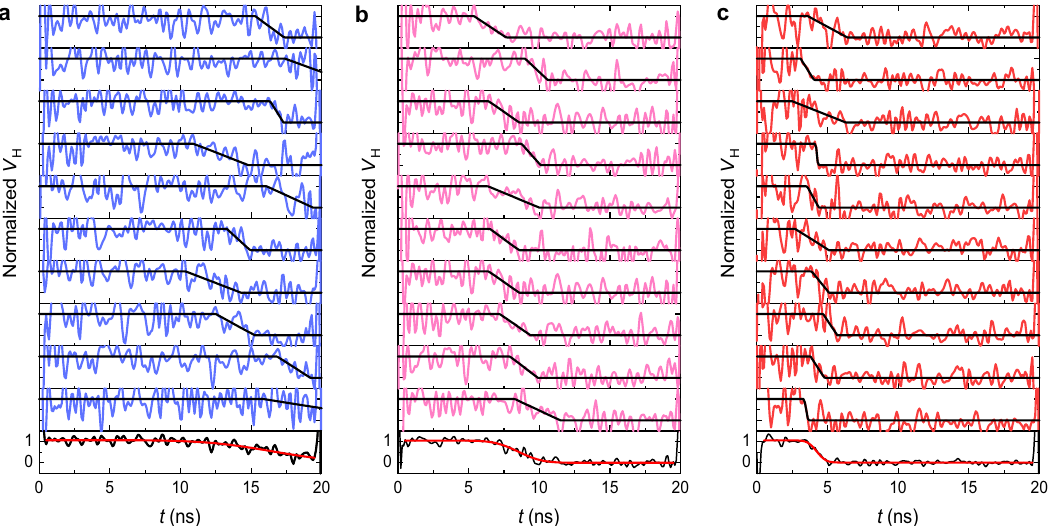
Fig. 3 Single-shot Hall-effect measurements. Normalized single-shot traces of Pt/GdFeCo dots for 20-ns-long pulses. The pulse amplitude is 1.4, 1.8, and 2.2 V in a , b and c , respectively. The in-plane magnetic fi eld is 125 mT. The pulse amplitude in a is close to the threshold switching voltage (see Supplementary Note 3). The black lines are fi ts to the traces with a piecewise linear function. The bottom-most curve in each graph is the average of the 10 traces above, fi tted with the cumulative Gaussian function